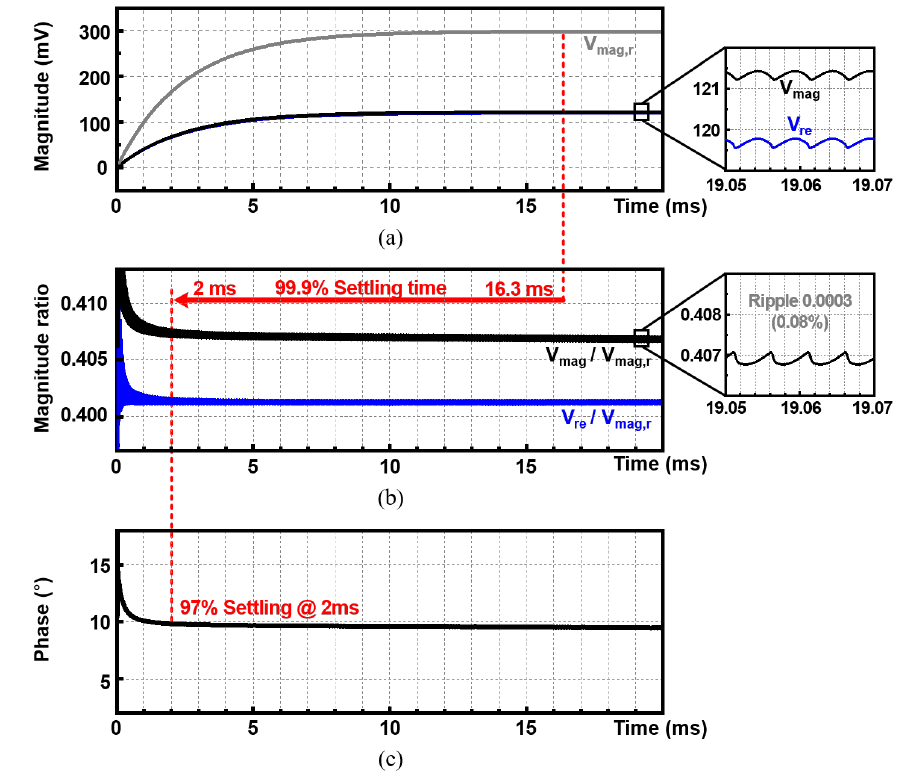
Figure 13. Transient simulated waveforms of ( a ) the reference magnitude output ( V mag , r ), measured magnitude output ( V mag ), real output ( V re ), ( b ) the ratio of them ( V mag / V mag , r and V re / V mag , r ), and ( c ) the phase results, when f in = 100 kHz, i in = 4 µ A pp , and A IA = 48.7